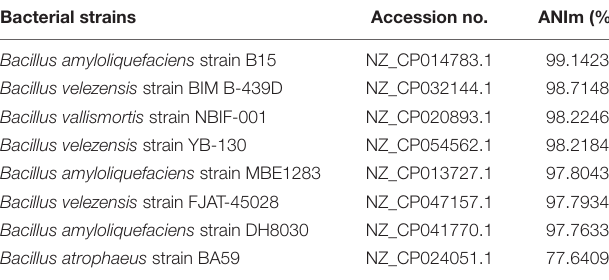
Frontiers in Microbiology |